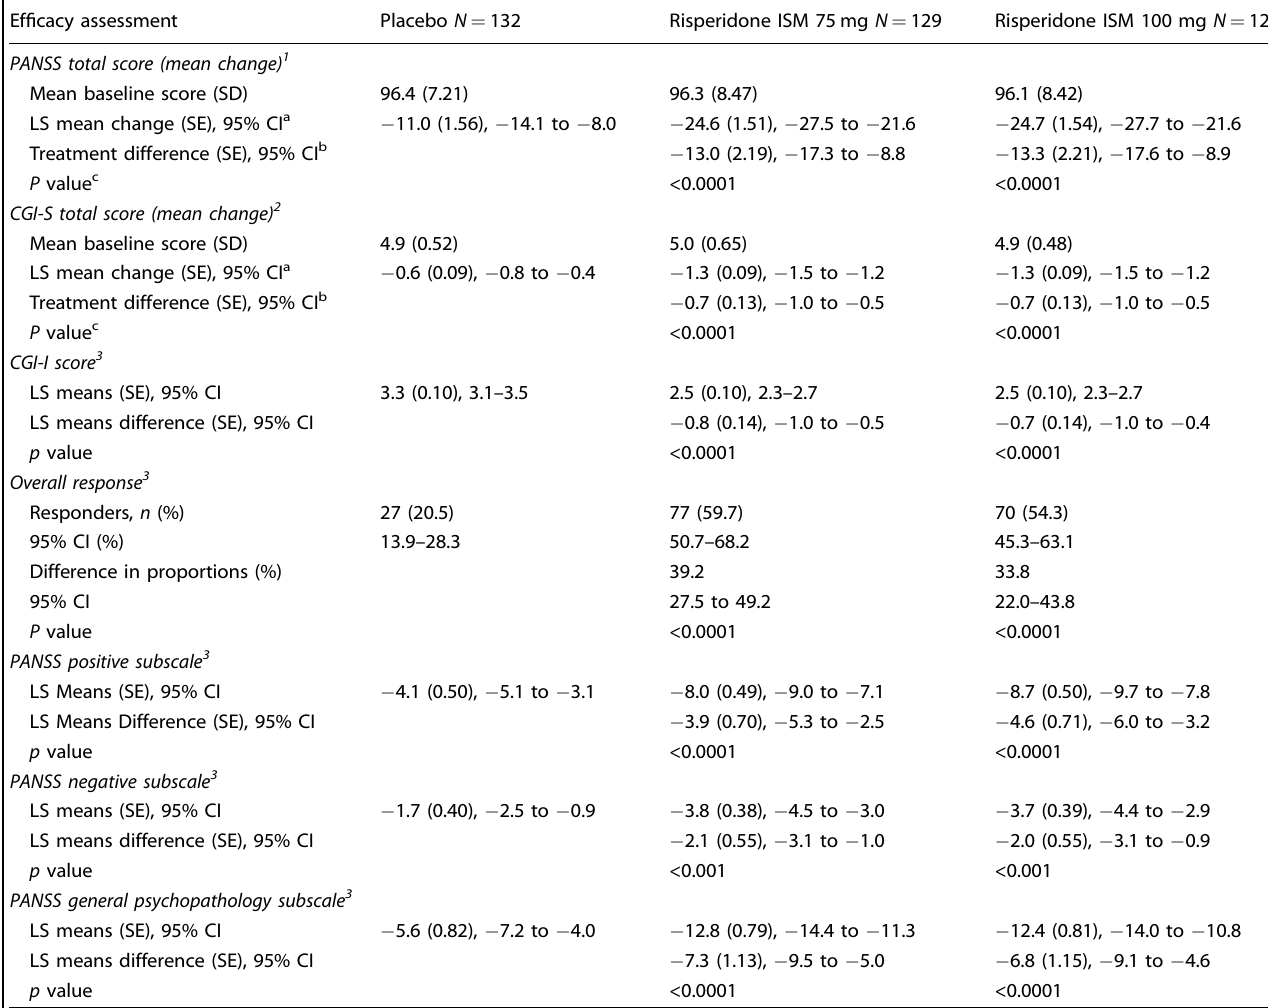
Table 2. Primary and secondary ef fi cacy assessments at endpoint (mITT